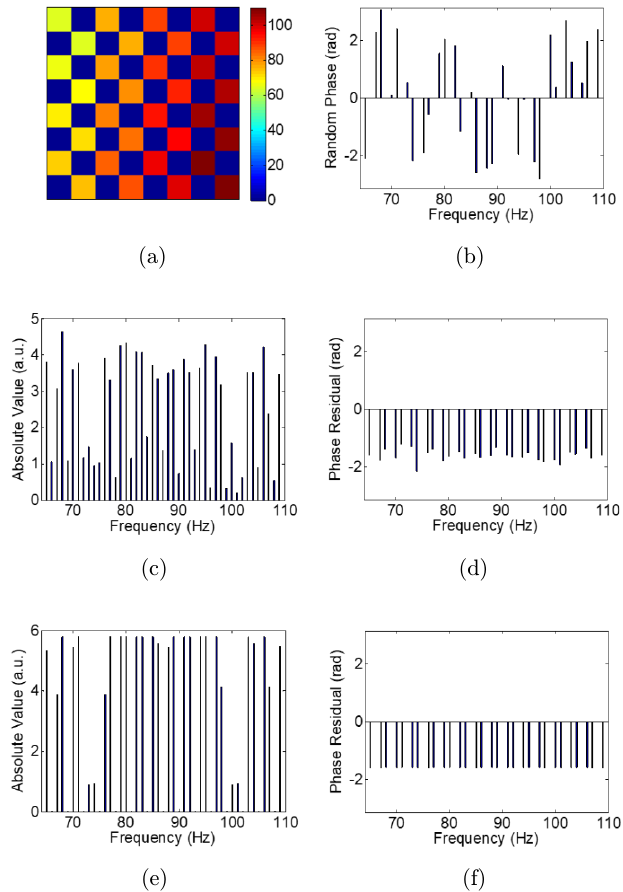
Fig. 2. (a) Phase elements labeled by modulation frequencies on the SLM. (b) Initial phase of each phase element. (c) Fourier transform of the raw feedback signal. (d) Phase residuals cor- responding to (c). (e) Fourier transform of the square root of the feedback signal. (f) Phase residuals corresponding to Fig. 2(b). The value of this initial phase is randomly